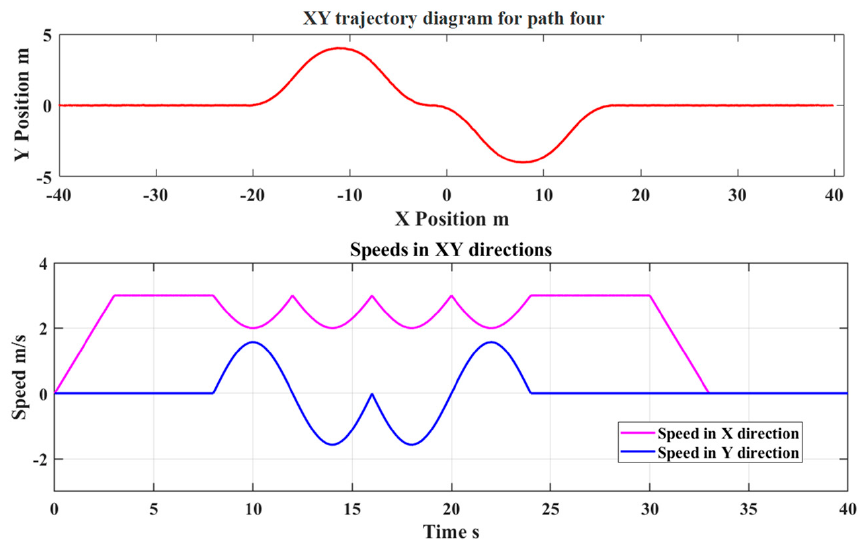
Figure 7. CLRV’s motion trajectory and speeds in the XY directions for desired path four. The initial position of the CLRV is ( − 40, 0). This path mainly comprises five parts: a uniformly accelerated straight motion part, two turning curves, uniform straight motions, and a uniformly decelerated straight motion part.